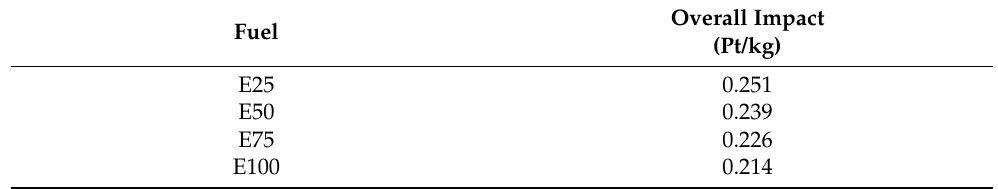
Table 5. Composition and environmental impacts of the gasoline–ethanol